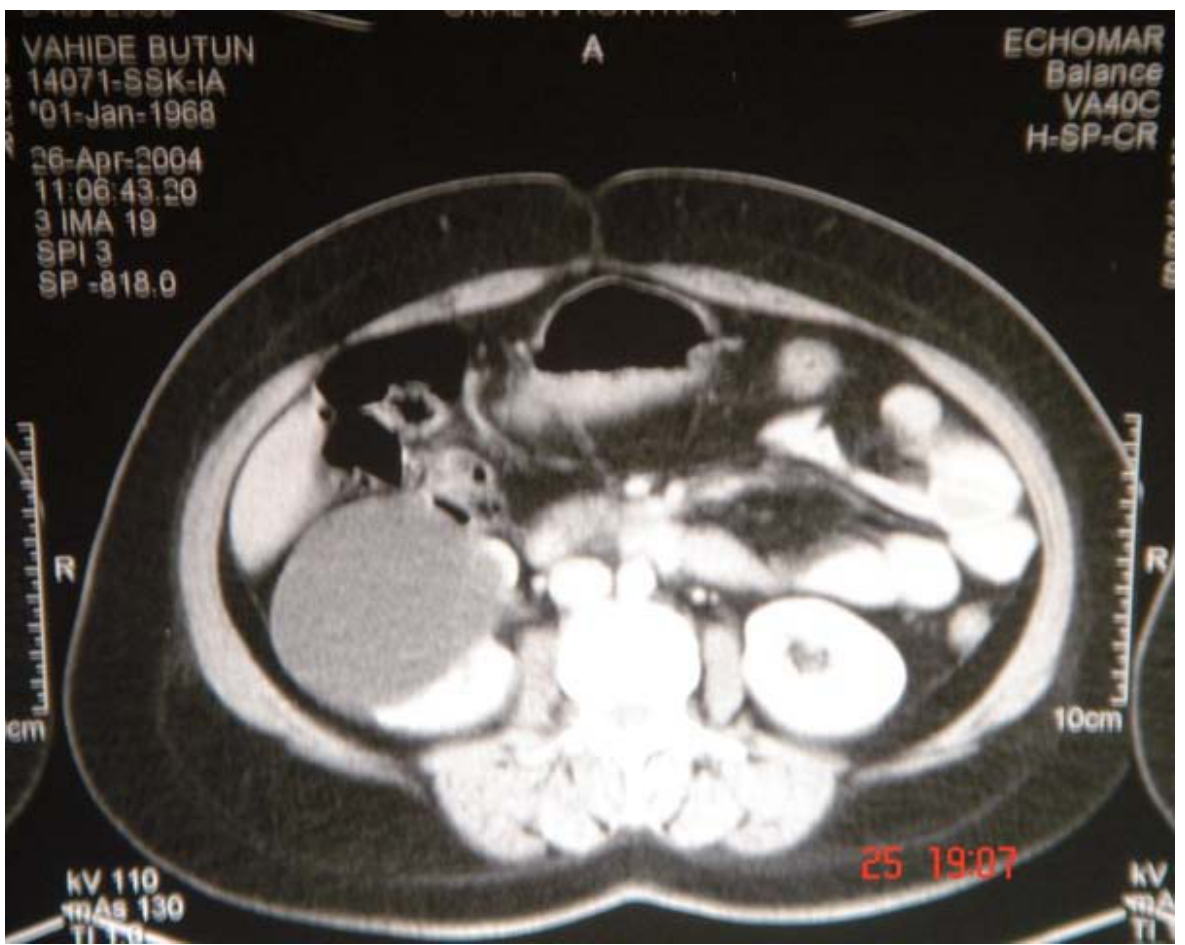
FIGURE 1. CT demonstrated the preoperative renal cyst after monosession ethanol